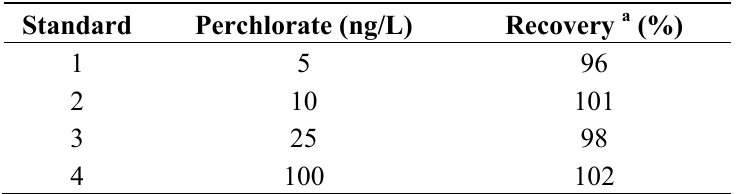
Note: a Average of